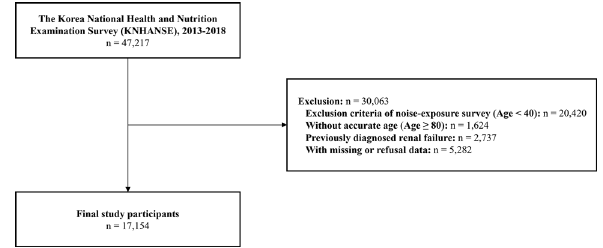
Figure 1. Flow chart of the study